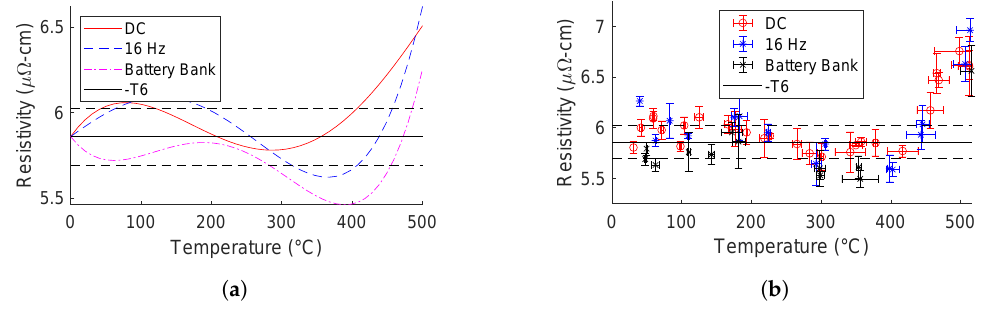
Figure 20. ( a ) Trend lines and ( b ) data points of all tests; Air-cooled,